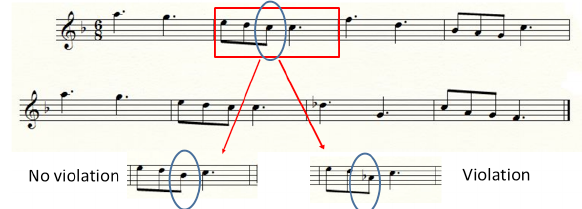
Figure 1. Example of the two types of note modification for a musical excerpt: No violation (same tone mode) versus Violation (violation tone mode).